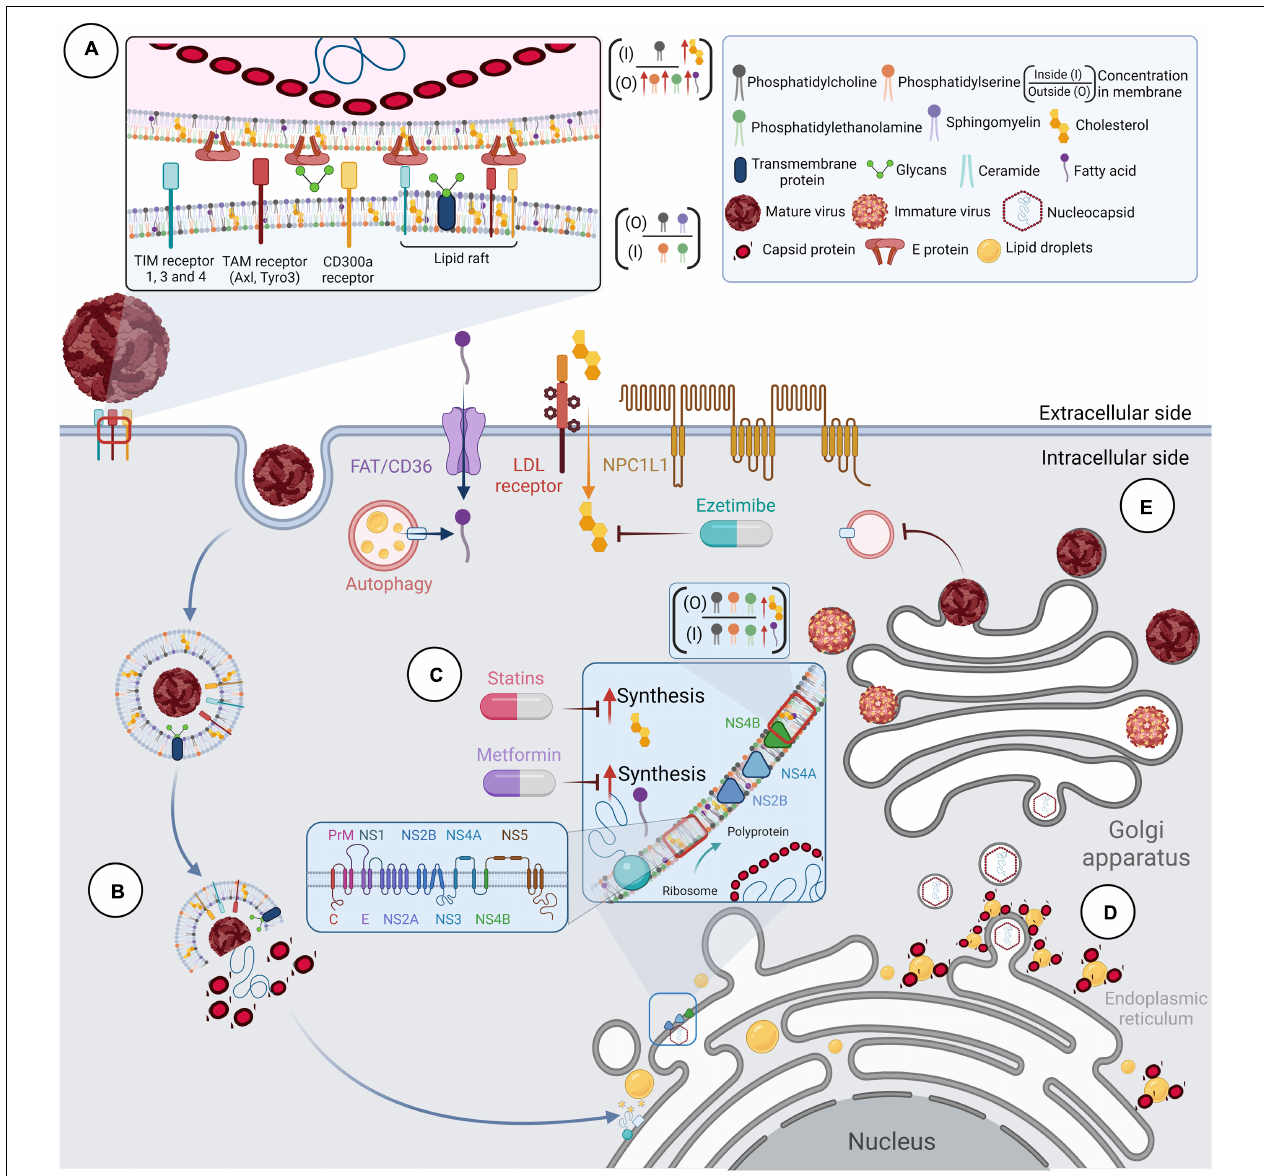
FIGURE 1 | Lipids and the replicative cycle of flavivirus. Flaviviruses depend on lipid metabolism to complete their replication cycle. (A) The membranes of Flaviviruses show a different composition than other cell membranes. Lipidomic, computational and functional studies suggest that flavivirus membranes are enriched with glycerophospholipids, sphingolipids, fatty acids, and cholesterol, all of which confer stability and robustness to the virion. During viral entry, contact with receptors allows internalization of the virion into the cell. These cellular receptors are usually coupled to lipid rafts in membranes with well-defined cholesterol concentrations and other membrane-stabilizing elements. (B) The viral genome release occurs in late endosomes using compartment-specific lipids. Lipids such as phosphatidylserine and phosphatidylethanolamine are involved in viral binding, entry, and fusion processes. (C) The viral RNA is translated into a polyprotein in the ER, which functions as a viral translation, replication, and morphogenesis platform. Infection-induced metabolic reprogramming leads to the accumulation of lipids required for viral replication. Lipid requirements are virus-dependent and cell-dependent; however, cholesterol and fatty acids appear necessary for the flavivirus cycle. (D) The involvement of lipid droplets (LDs) has been reported during viral replication and assembly. The co-localization and interaction of protein C with LDs have also been described during WNV, DENV, JEV, and ZIKV infections. (E) Finally, immature viral particles travel through the Golgi apparatus to complete their maturation